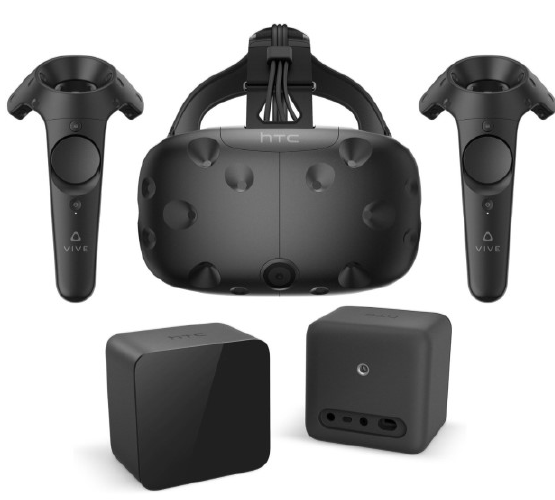
Figure 1. The basic components of the HTC Vive ®